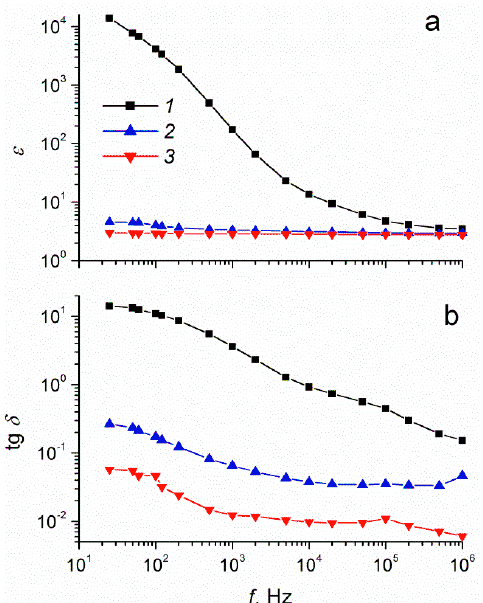
Figure 1. Frequency dependences of ( a ) the dielectric constant and ( b ) the dielectric loss tangent for 40 wt% suspensions of tungsten oxide (WO 3) (1), WO 3 / sodium dodecyl sulfate (SDS) (2), and WO 3 / dodecylamine (DDA) (3).